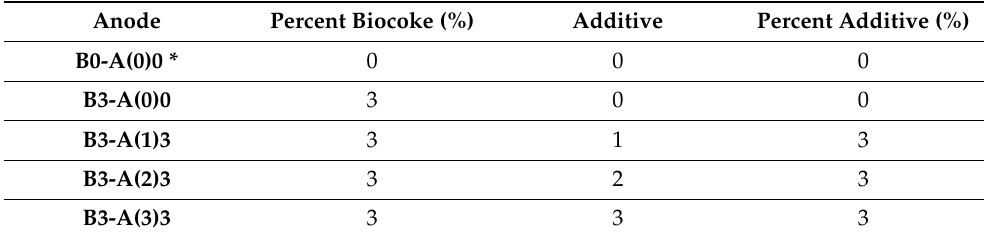
Table 2. Composition of the